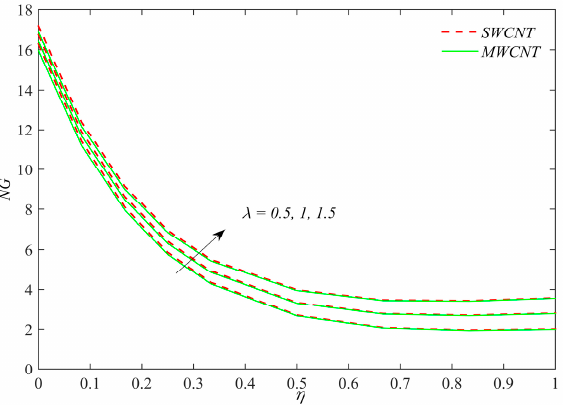
Figure 21. The variation of the entropy optimization NG for the case of SWCNT and MWCNT versus the similarity variable for the distinct values of the diffusive constant parameter λ .